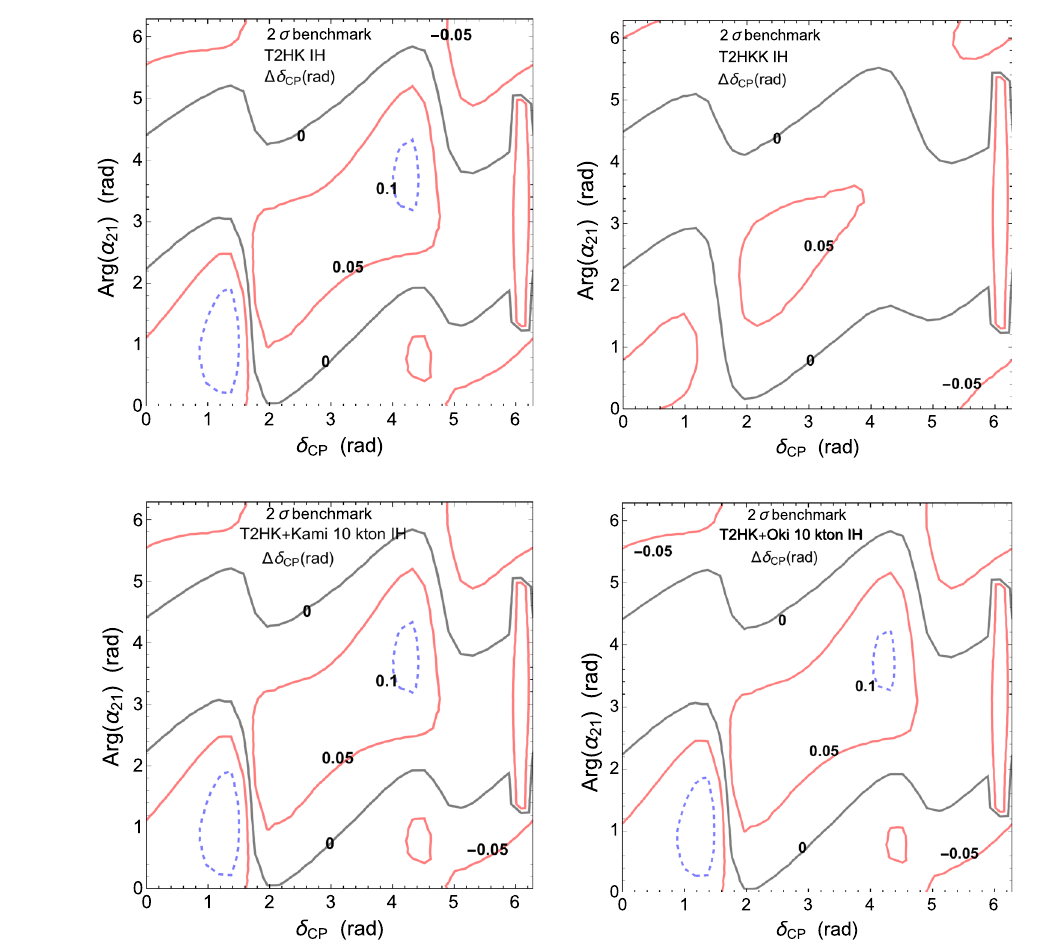
Fig. 16 The difference between the true value of δ CP , and the value that minimizes χ 2 ((cid:20)) of Eq. (32) (cid:10)δ CP with the true mass hierarchy. The benchmark with Eq. (37) is assumed, and the true mass hierarchy is inverted. The upper-left, upper-right and lower-right subplots corre- spondtotheT2HK,theT2HKK,andtheplanoftheT2HKplusa10kton